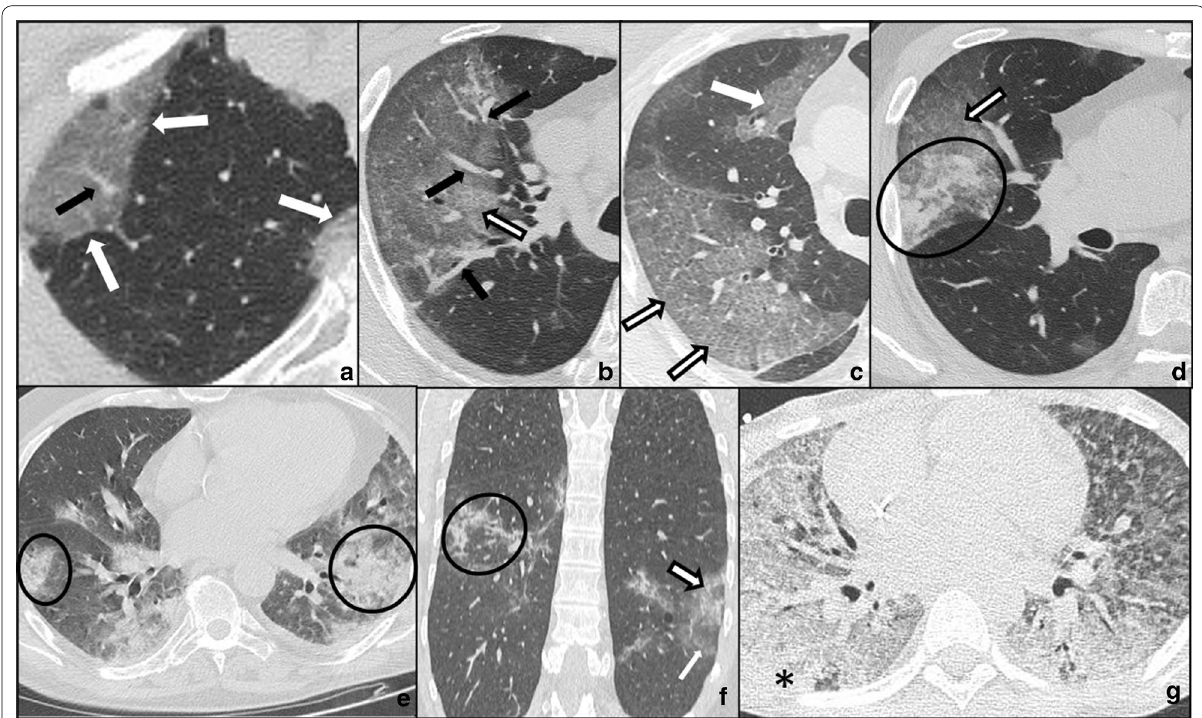
Fig. 1 a – g COVID-19 pneumonia phases. HRTCs of patients showing the different phases and possible evolutions of COVID-19 pneumonia. In a, two subpleural, sharply demarked ground-glass opacities (white arrows in a ) indicate phase 1. There is evidence of concomitant widening of peripheral vessels (black arrow in a ). In b and c , subpleural extensive areas of ground glass (white arrow in c ) and crazy paving pattern (black bordered white arrows in b , c ) are referable to phase 2. Black arrows in b indicate dilatated segmental and subsegmental vessels. Phase 2 may also be characterised by extensive areas of crazy paving (black bordered white arrow in d ), in which small consolidative foci are evident (black circle in d ); In e , dependent and non-dependent consolidations (black circles in e ) are hallmarks of phase 3. Phase 4 ( f ) presents as irregular consolidative foci (black circle in f ) coexisting with confluent ground-glass opacities (white arrow in f ) and crazy paving pattern (black bordered white arrow in f ), whereas ARDS, which represents a possible complication COVID-19 pneumonia, is characterised by dependent consolidations (black asterisk in g ) and widespread ground-glass